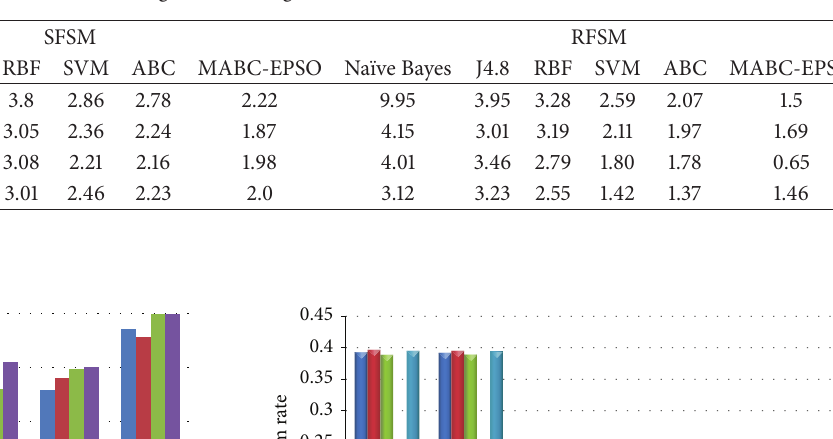
Table 14: Training time of classification algorithms using SFSM and RFSM feature selection methods.